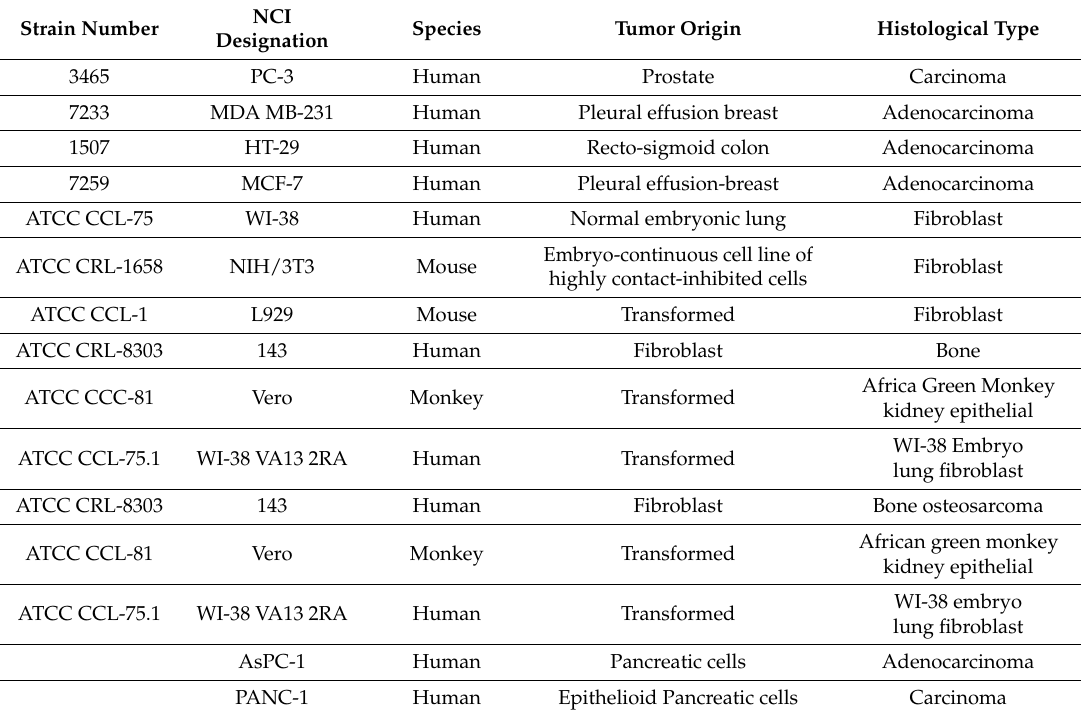
Table 3. Cell line characteristics and